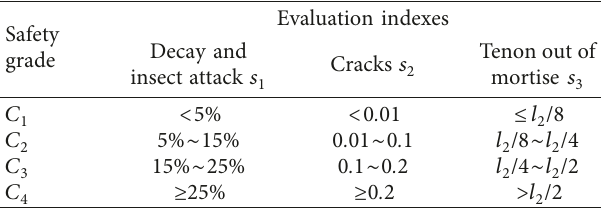
Table 6: Safety grade classification for mortise and tenon joints.